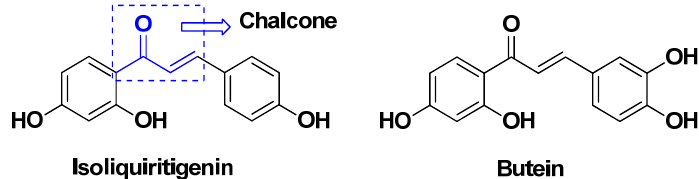
Figure 104. Pyrrolo ‐ benzodiazapine containing FDA approved anticancer drug.